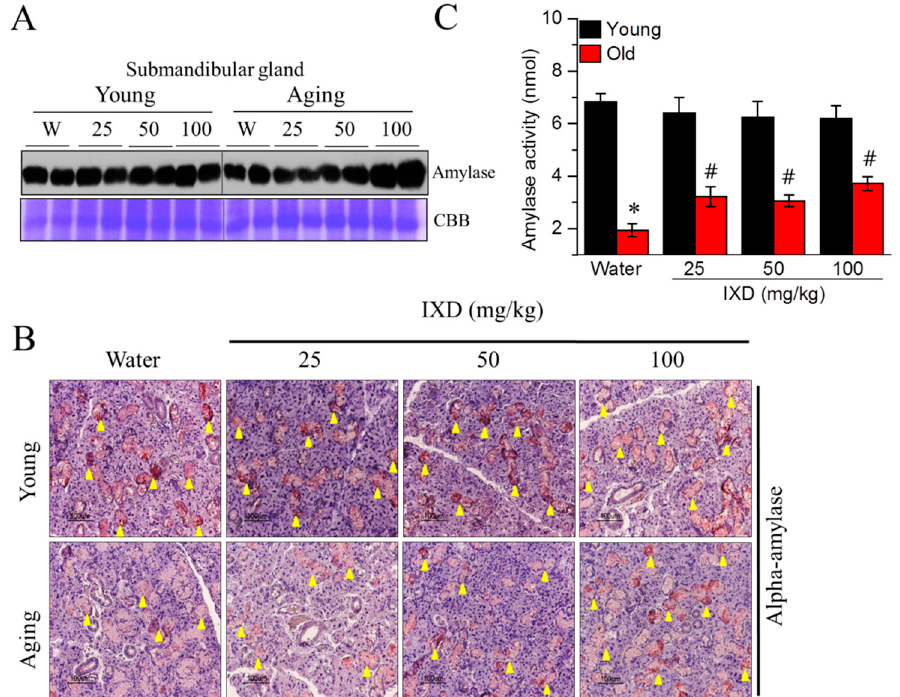
Figure 3. IXD extract increases alpha-amylase expression and water channel activation in aged submandibular glands. ( A ) Amylase protein expression, shown by western blot analysis; ( B ) Immunostaining was performed in submandibular glands using the alpha-amylase antibody. Yellow arrowheads indicate positive staining of alpha-amylase; Magnification: 400×, Scale bar: 100 µm; ( C ) Measurement of salivary amylase activity. Values are presented as mean ± SEM. * p < 0.05 vs. young control rats, # p < 0.05 vs. old control rats.